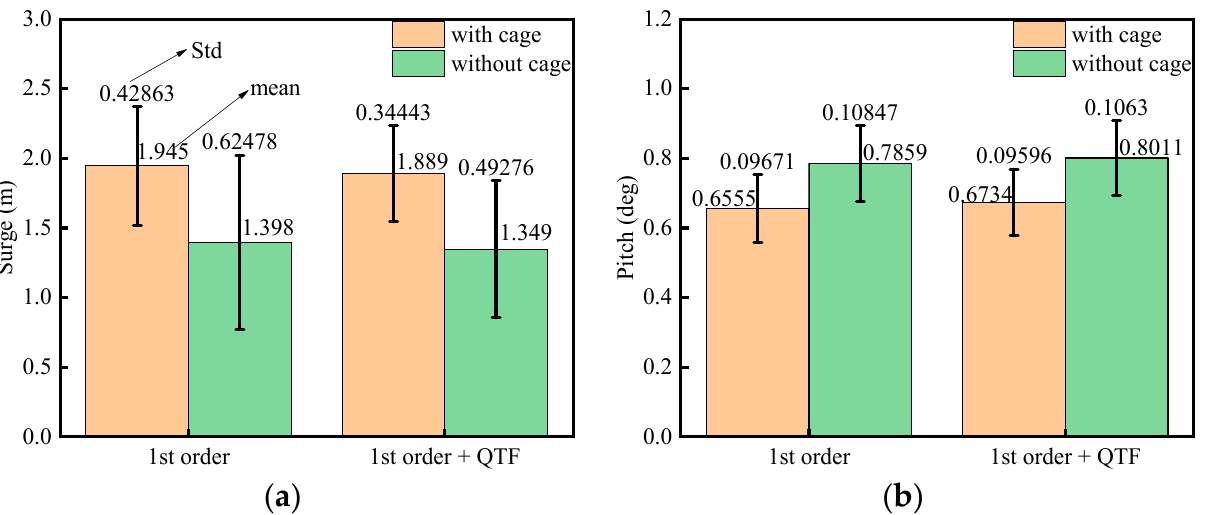
Figure 13. Comparison of motions for the barge-type FOWT-AC and barge-type FOWT at first order